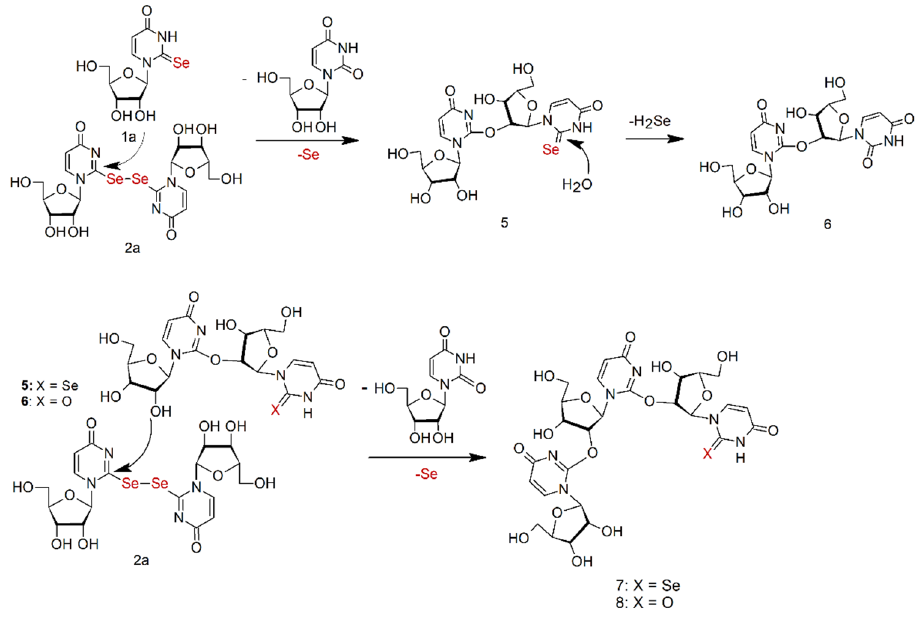
Scheme 2. Conversion of 2 with 1 to seleno-dinucleosides 5 and seleno-trinucleosides 7 and their deselenated analogs 6 and 8 , respectively. The structures of the regioisomers with internucleoside C2-2 ′ O bonds are shown.